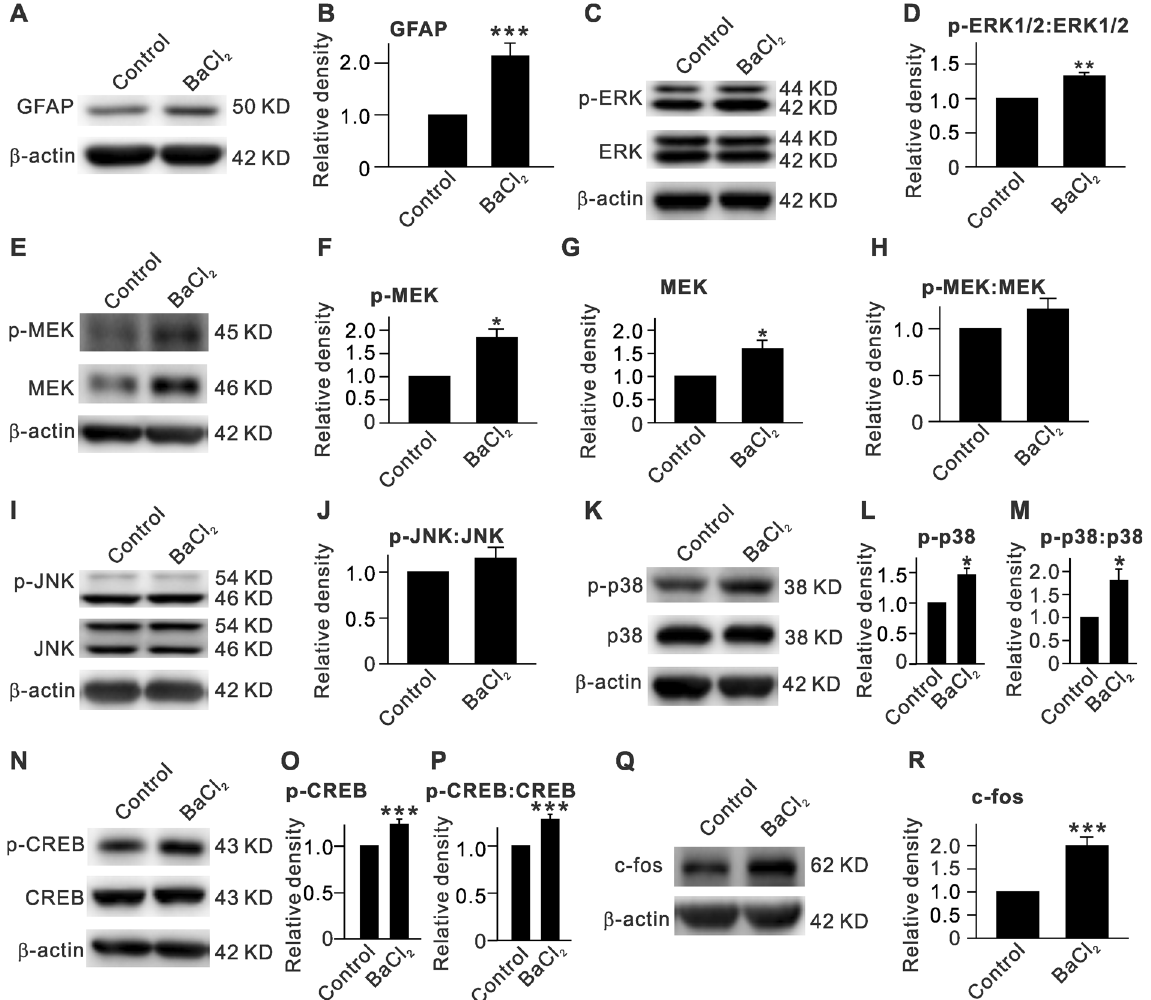
** P < 0.01 and *** P < 0.001 vs .